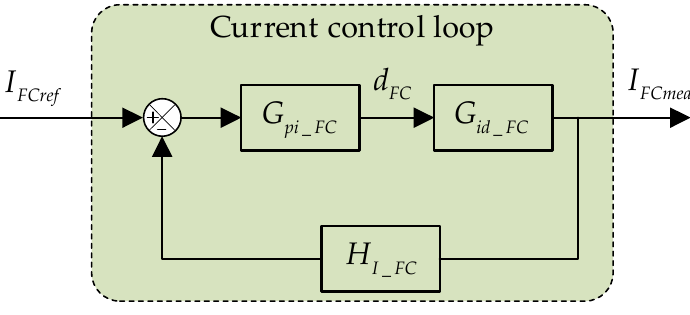
Figure 15. Current controller diagram of the PEMFC converter.